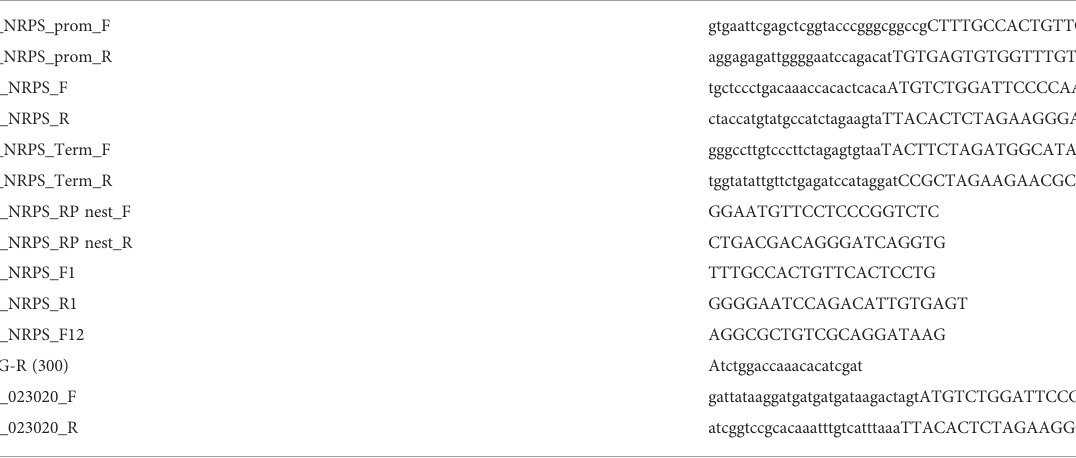
TABLE 2 Oligonucleotide primers used in the